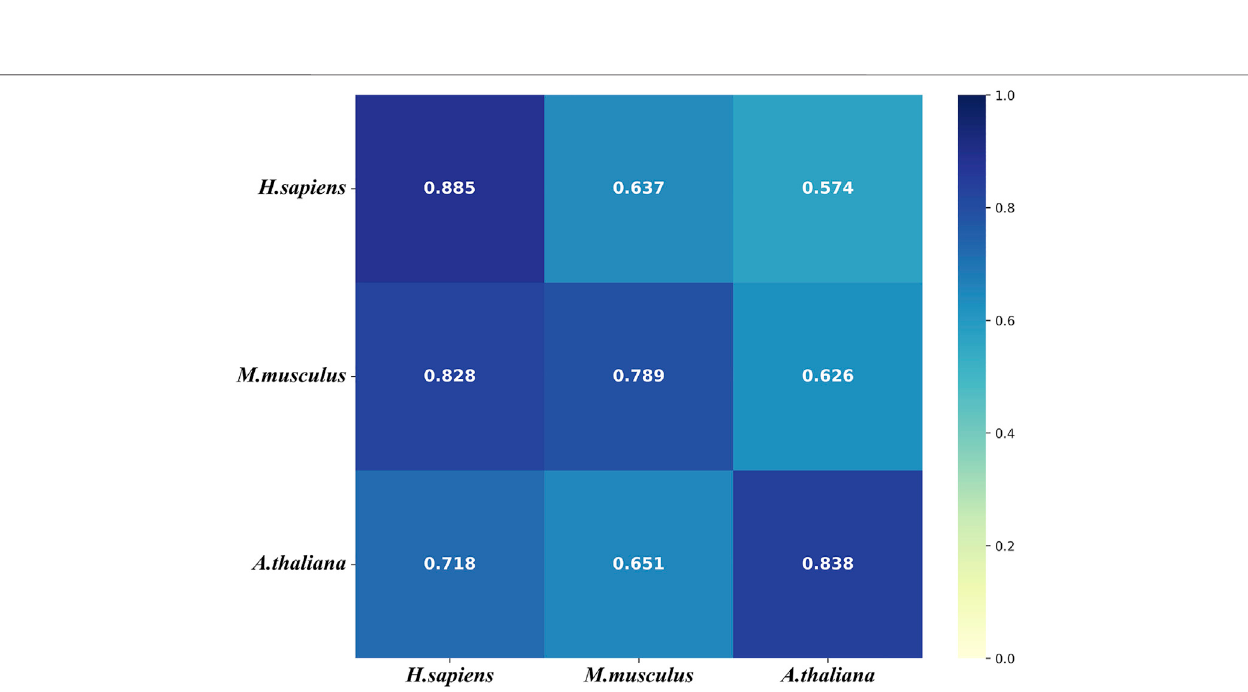
Frontiers in Genetics |